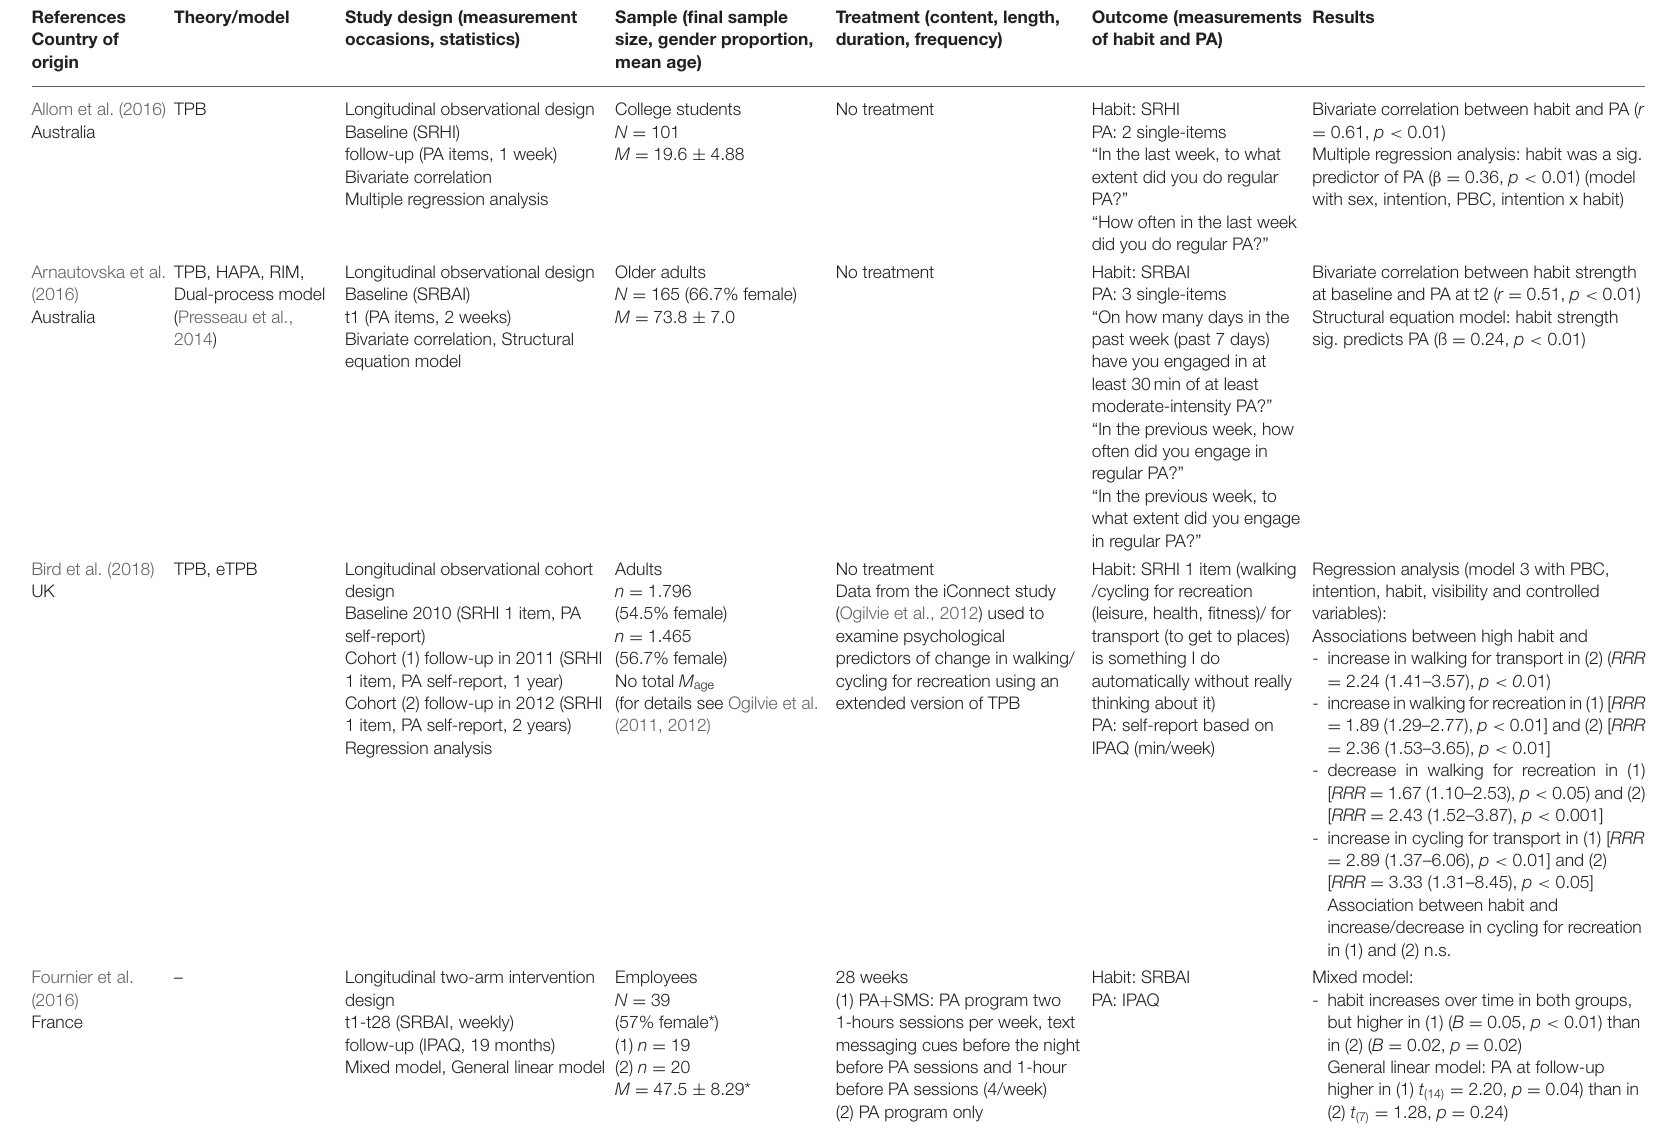
TABLE 2 | Data extraction of included